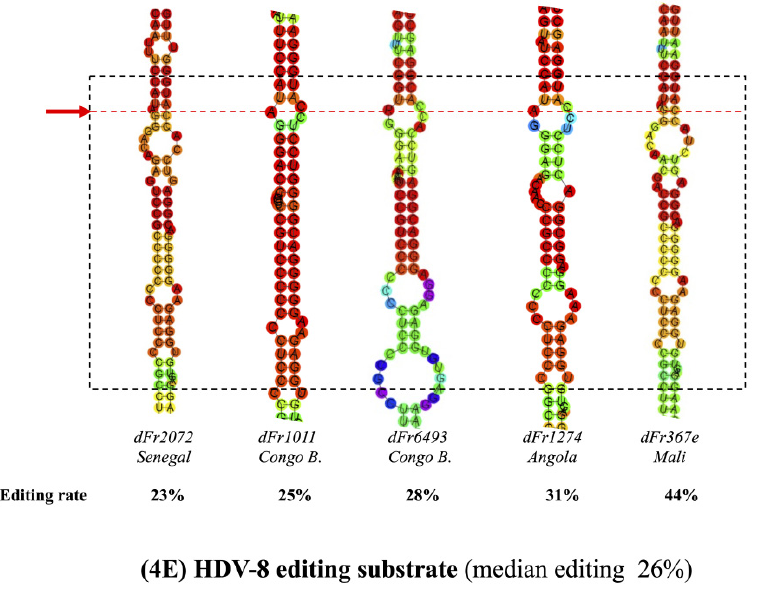
Figure 4. Secondary structures of editing substrate regions from different HDV genotypes: panel ( A – E ) for respectively for HDV-1 (10 strains); HDV-5 (7 strains); HDV-6 (5 strains); HDV-7 (5 strains) and HDV-8 (5 strains) . These more stable profiles result from the analysis of 32 HDV RNA secondary structures were predicted from full-length antigenome sequences and focus on the amber/W editing site and the 25 downstream nucleotides. The dashed black square delimitates the minimal editing substrate region. The red dashed line corresponds to the amber/W codon and the A-C mismatch at position 1012 of the antigenome. For each strain, its name, country of origin, genome size, free energy to destabilize the structure and editing rate are indicated. The dFr7024 strain (HDV-7; (panel D ) displays a particular secondary structure in which the unbranched rod-like is rearranged to form to two stem-loops (SL1 and SL2) that flank a central base-pairing region that includes the amber/W site. The color scale indicates the relative base-pairing probabilities from 0 (violet) to 1 (red).